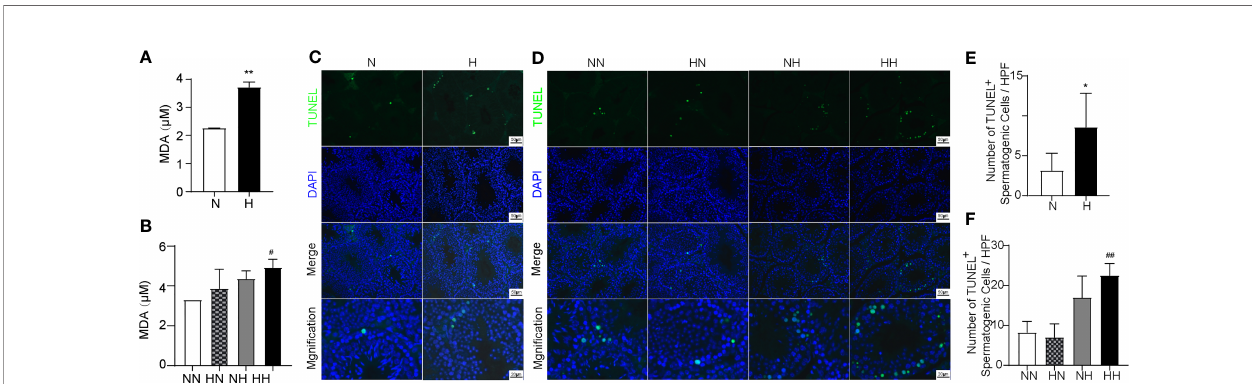
FIGURE 6 | Oxidative levels and germ cell apoptosis induced by high-fat diet during sexual development. Testicular MDA content of 8-week and 16-week old mice (A, B) Testicular tissue TUNEL staining of 8-week and 16-week old mice (C, D) . The TUNEL+ cells/ fi led of spermatogenic cells were calculated (E, F) (n=3 for each group). Arrows show TUNEL-positive spermatogonia, arrows head show TUNEL-positive primary spermatocyte. Results are presented as mean ± SEM. *p < 0.05, **p < 0.01 vs the N group. #p < 0.05, ##p < 0.01 vs the NN